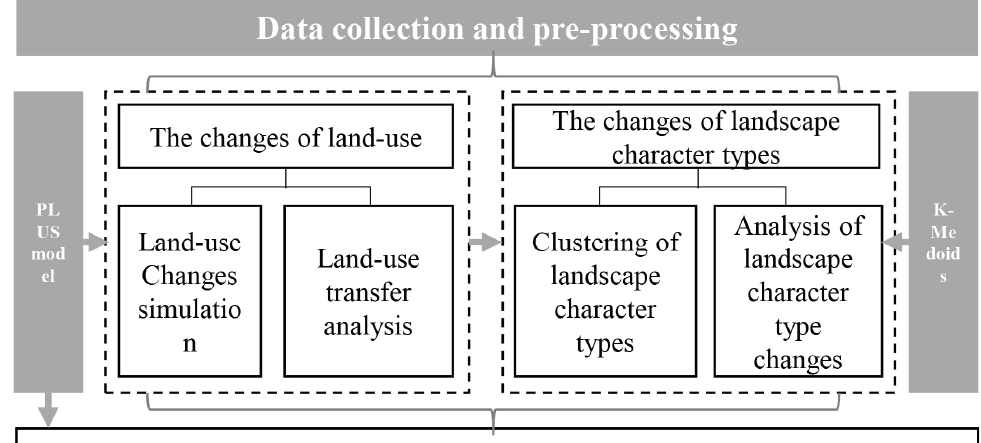
Figure 2. Research framework.